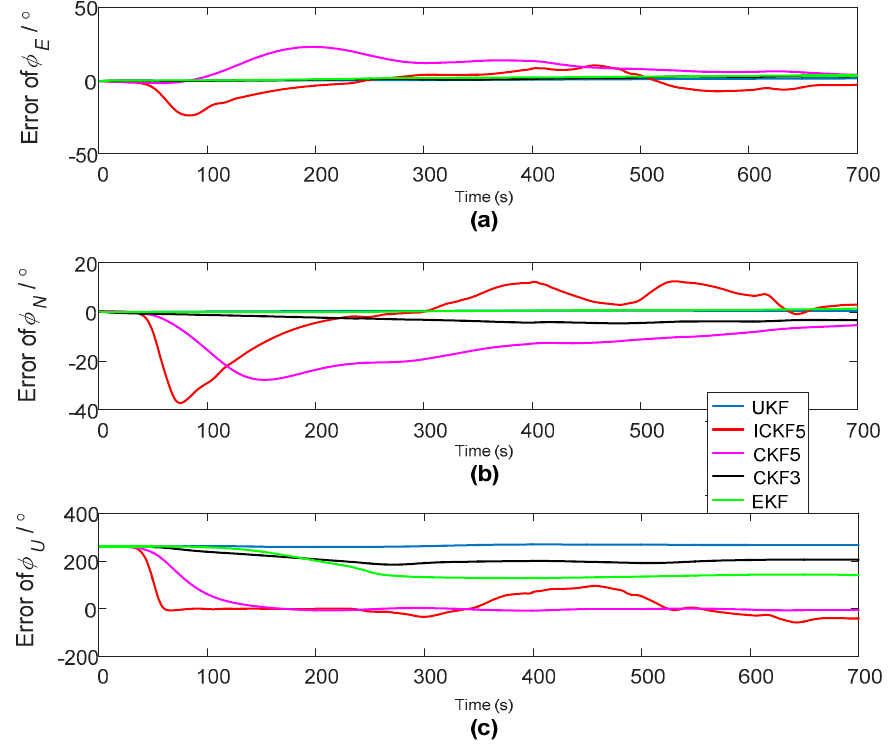
Figure 7. The alignment errors of large azimuth misalignment angle of dynamic vehicle experiment: ( a ) Pitch errors; ( b ) roll errors; ( c ) heading errors.